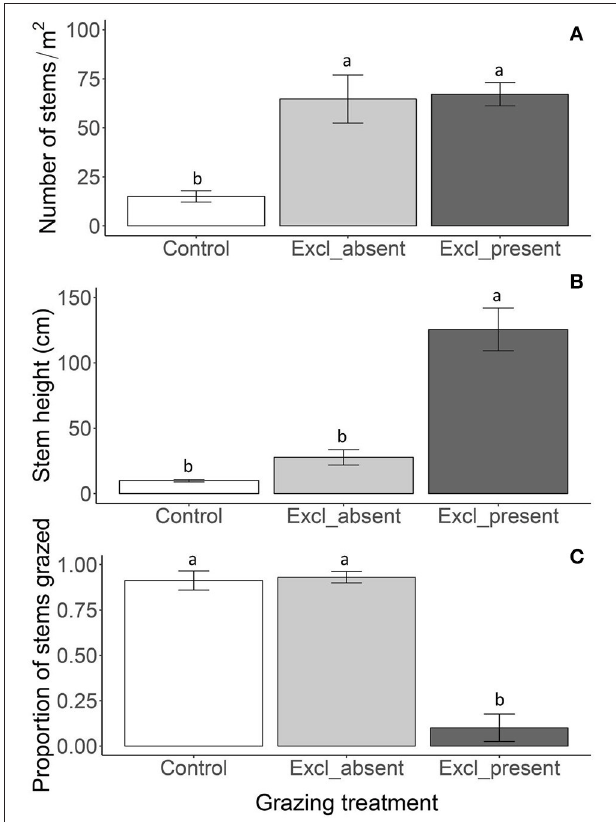
FIGURE 3 | Reed density (A) , stem height above the water (B) and proportion of grazed stems (C) in July 2011 in the control plots, plots where exclosures were removed (exclosure_absent) and exclosures (exclosure_present). The exclosure absent treatment consisted of reed which had been protected for 5 years by fencing, whereas now fencing had been removed before the start of the growing season. The exclosure present treatment had kept its fencing. Data are means ± SE, n = 6 for the control plots and n = 3 for the exclosure present and absent treatments respectively. Different letters indicate significant differences among the grazing treatments at P <